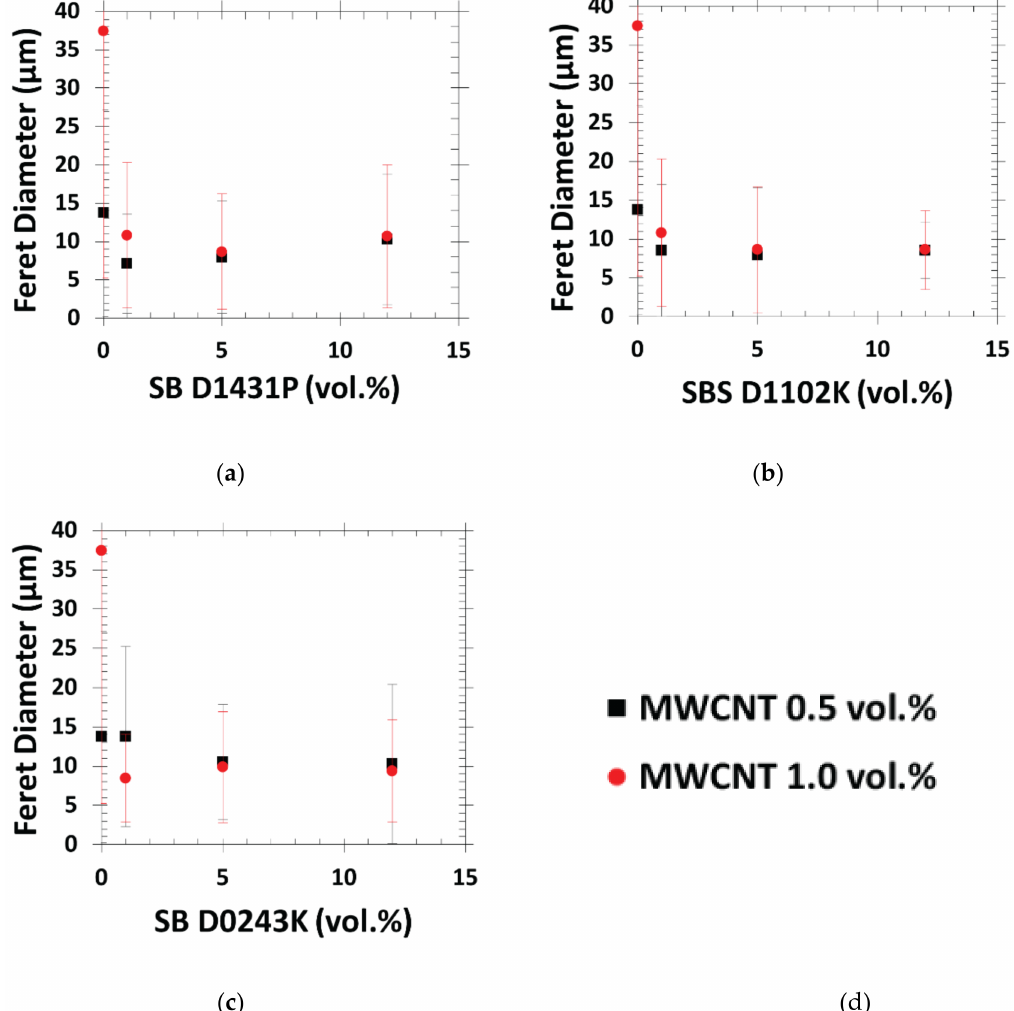
Figure 7. Emulsification curves of 0.5 vol.% and 1.0 vol.% MWCNT filled ( a ) PP:PS/70:30/SB-D1431P, ( b ) PP:PS/70:30/SBS- D1102K, and ( c ) PP:PS/70:30/SB-D0243K. ( d ) Description of the MWCNT concentration. The upper and lower horizontal axes in each plot corresponded to the copolymer concentration in the minor phase (PS) and to the copolymer overall concentration in the nanocomposite,